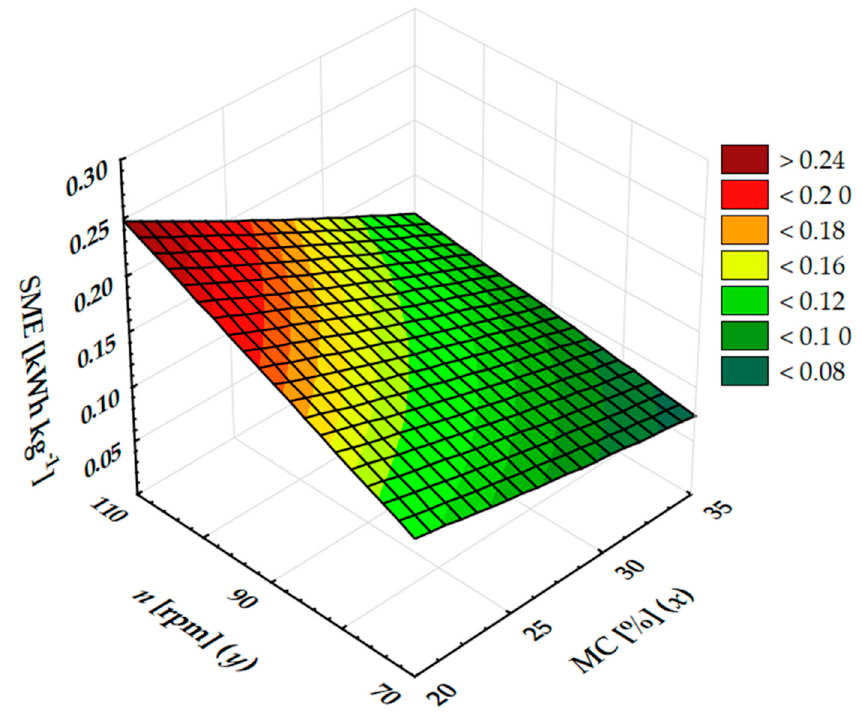
Figure 3. The influence of the rotational speed of the extruder screw and the level of raw material moisture on the energy consumption of the extrusion process.